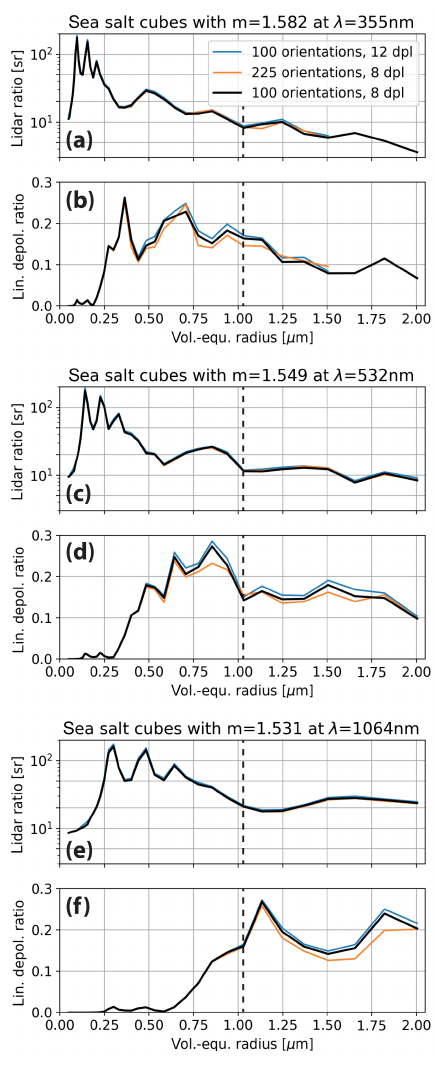
Figure 15. Simulation of the lidar ratio and the particle linear de- polarization ratio for sea salt cubes depending on volume equiva- lent radius. The three lidar wavelengths are treated separately. The model simulations with increased number of dipoles (blue line) and orientations (orange line) are given as an estimation of the uncer- tainty. A dashed line marks the effective radius ( r eff = 1 . 033µm) of the AERONET size distribution given in Fig. 16. For the simula- tions of the cubic sea salt particles, the radius of the particles was reduced by a factor of 2. Details are given in the text.